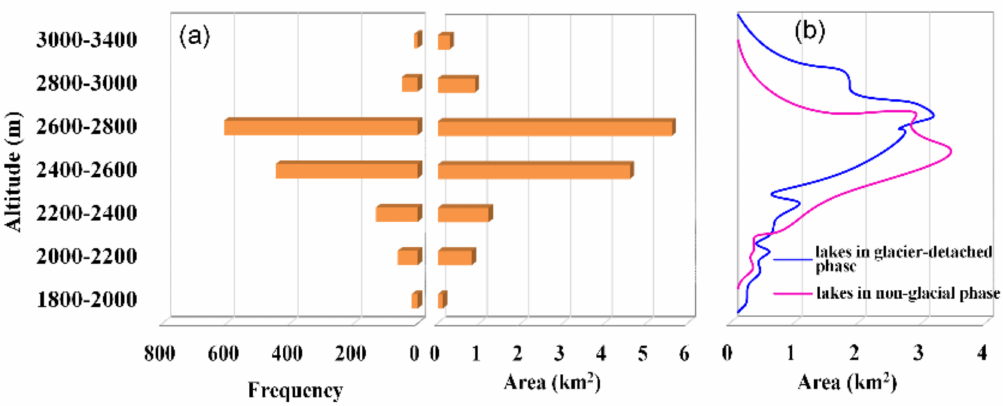
Figure 8. Altitudinal characteristics of glacial lakes in Altai Mountains by ( a ) Frequency and area, and ( b ) Different types of